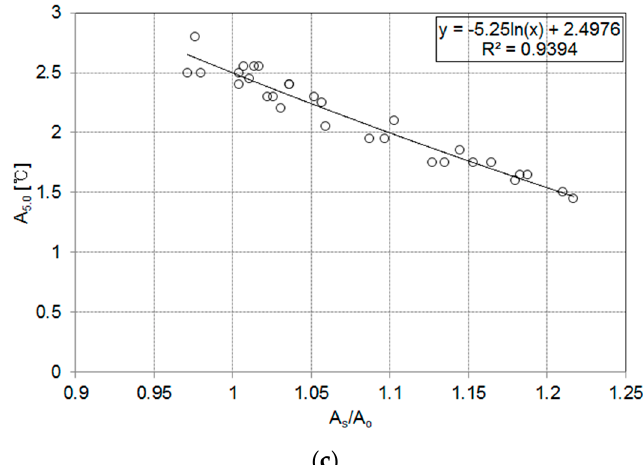
Figure 3. Regression analysis to determine amplitude at underground depths with respect to the amplitude ratio of ground surface and outdoor temperature waves: ( a ) amplitude ( A 1.0 ) at underground depth of 1 m; ( b ) amplitude ( A 3.0 ) at underground depth of 3 m; ( c ) amplitude ( A 5.0 ) at underground depth of 5 m.